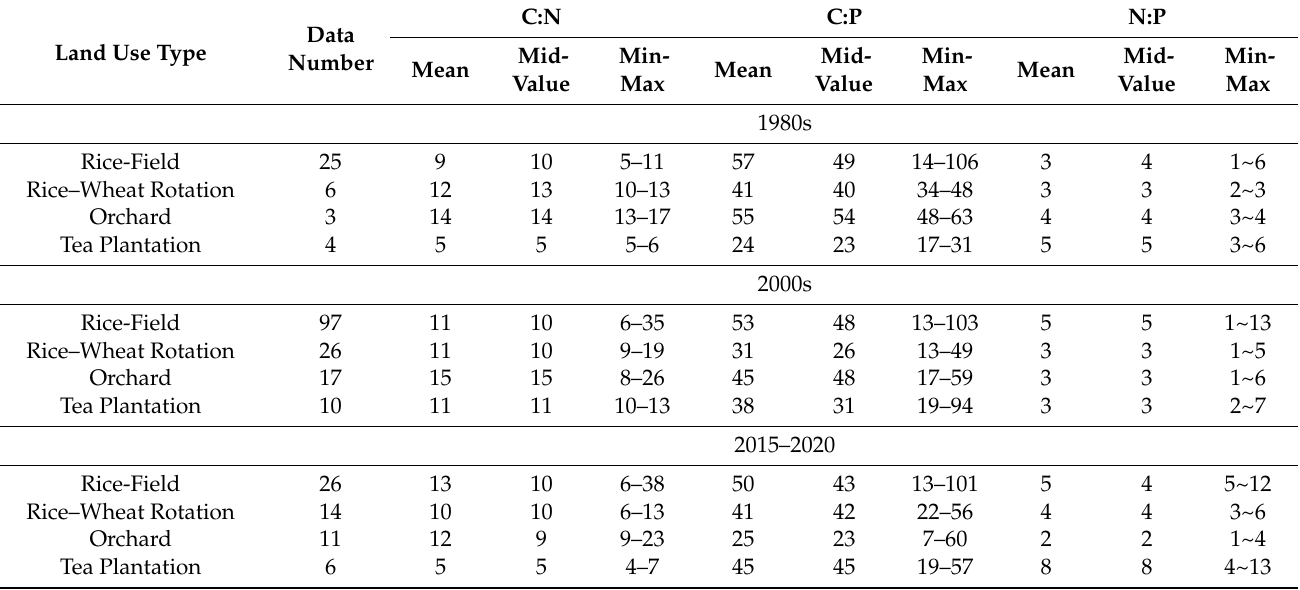
Table 2. Topsoil C:N, C:P, and N:P ratio under different agricultural land use types (ALUTs) in Taihu Lake basin according to meta-data